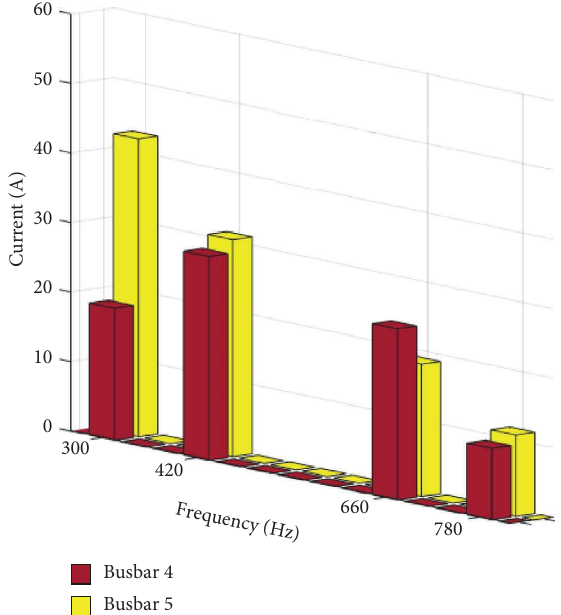
Figure 6: Case 1-Harmonic Current Spectrum in busbars 4 and 5.